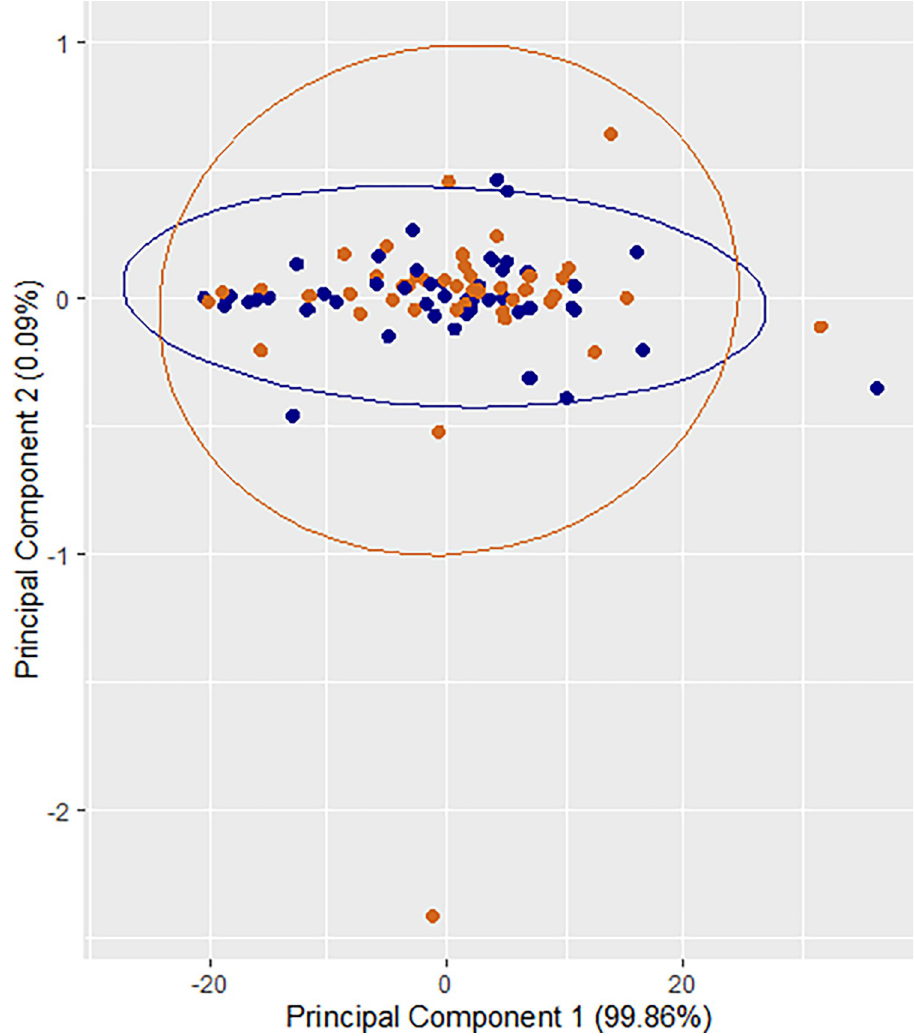
Fig 2. Principal component analysis bi-plot for comparing the relative metabolite intensities of IVF and ICSI derived sibling embryos. PCA plot (PC 1 vs PC 2 ) of SCM demonstrated random distribution of metabolites between IVF and ICSI derived embryos. Each dot represents a single sample. Blue dots (•) represents IVF derived SCM whereas orange dots (•) represents ICSI derived